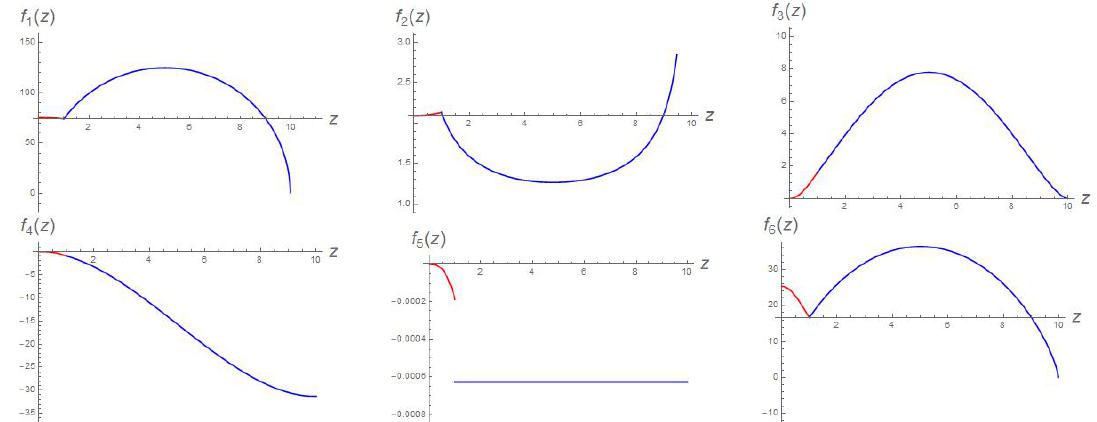
Figure 16. f i ( z ) for the dual background to the quiver in (cid:12)gure 5.